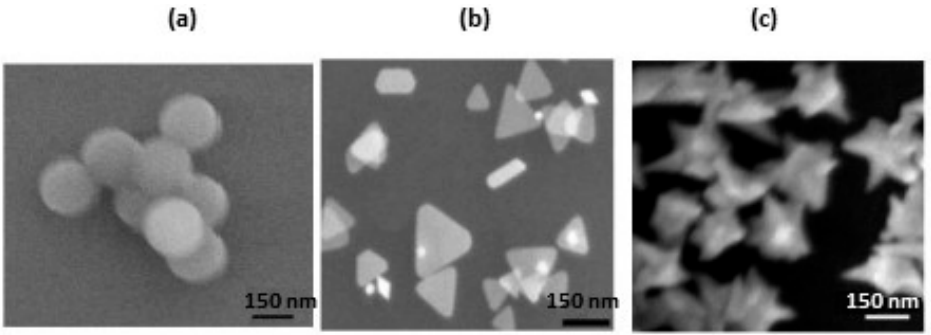
Figure 1. SEM images of the following gold nanostructures: ( a ) nanospheres; ( b ) nanotriangles, and ( c ) nanostars. Reproduced with permission from Royal Society of Chemistry, 2014 [59].